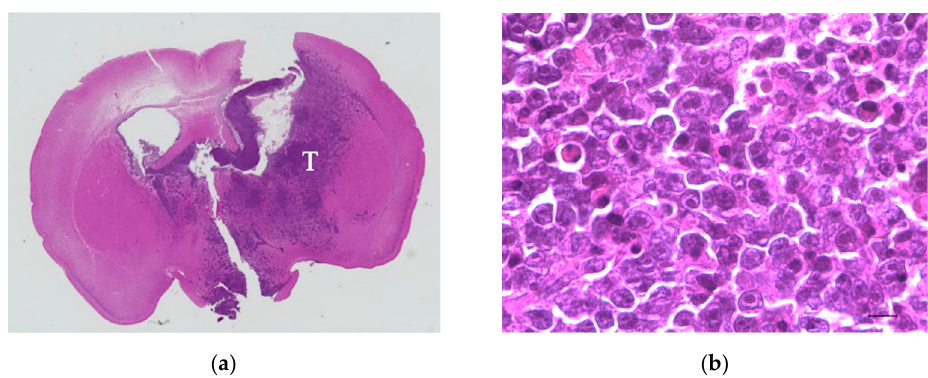
Figure A1. Representative aspect of CNS lymphoma sections stained with hematoxylin-Eosin (HE). ( a ): Photomicrographs of brain parenchyma after Raji lymphoma cells implantation. The mice were sacrificed when the body weight was reduced by 25%. The brain was removed and sectioned serially. The character T in the figure represents tumor formation (×4). ( b ): Perivascular cuffing and diffuse proliferation of microblasts typical of lymphomas is seen (×100).